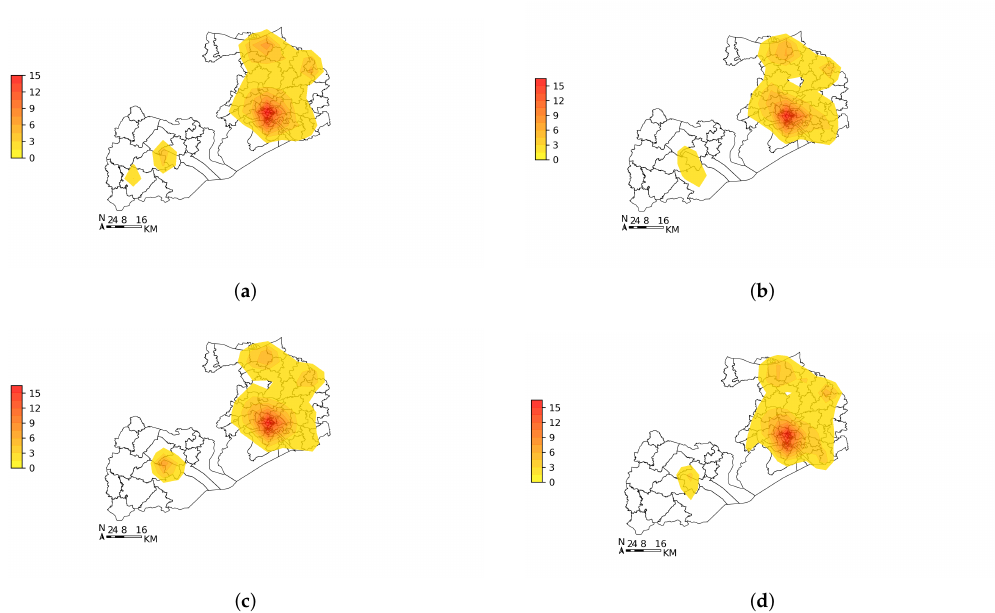
Figure 7. Heat map of spatial distribution of travel hotspots. ( a ) Hotspots of Monday. ( b ) Hotspots of Thursday. ( c ) Hotspots of Saturday. ( d ) Hotspots of